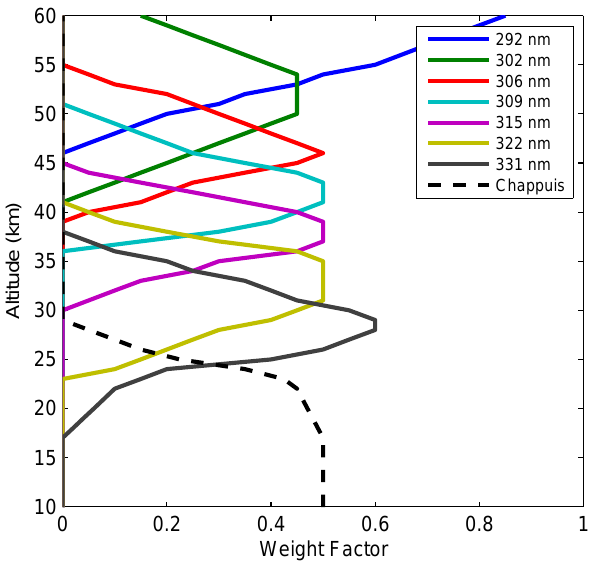
Fig. 4. The weighting factors assigned to each of the vectors as a function of